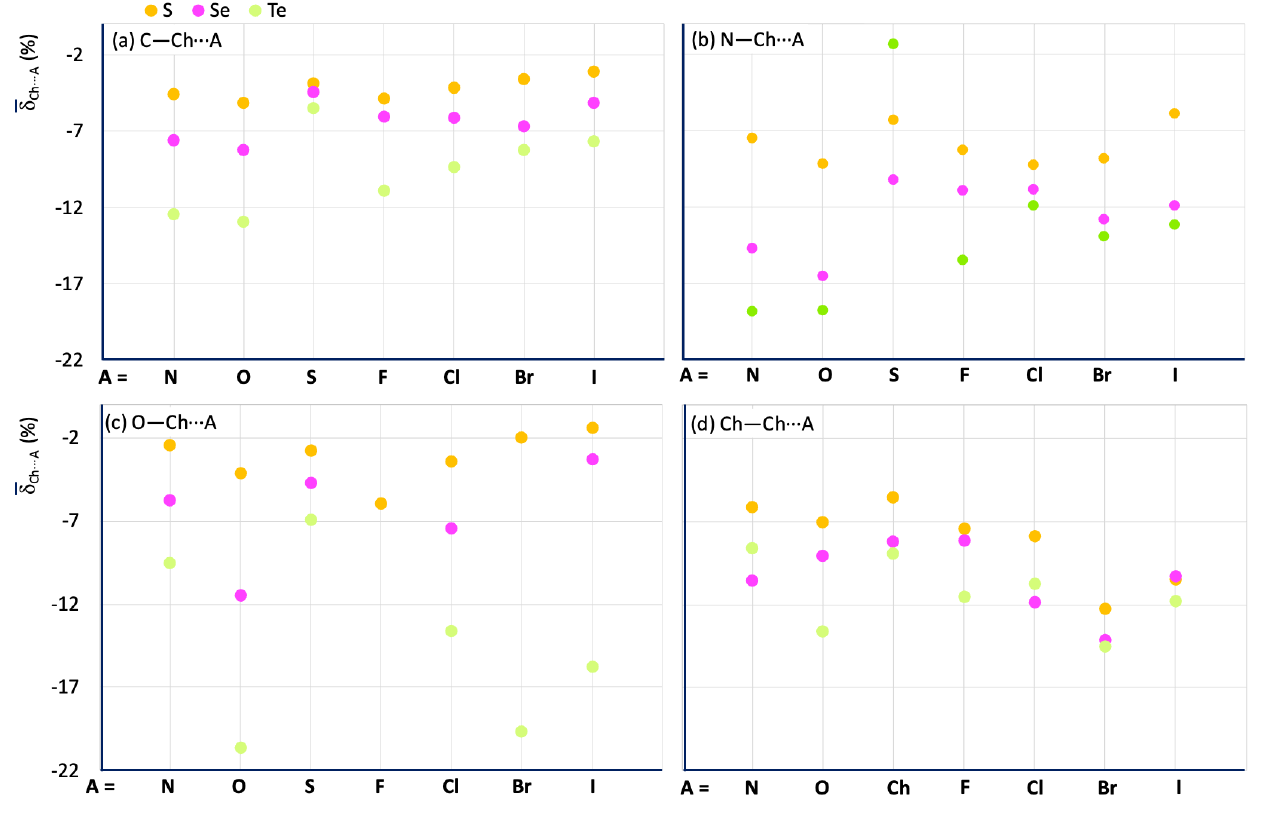
Figure 11. Mean δ̅ Ch···A values calculated for the R – Ch···A fragments. R = C ( a ), N ( b ), O ( c ), and Ch (i.e., S for S, Se for Se, and Te for Te) ( d ) for Ch = S (yellow), Se (magenta), and Te (acid green). Table 4. Average δ av(Ch ··· A) value of the mean δ Ch ··· A values calculated for all the A acceptors